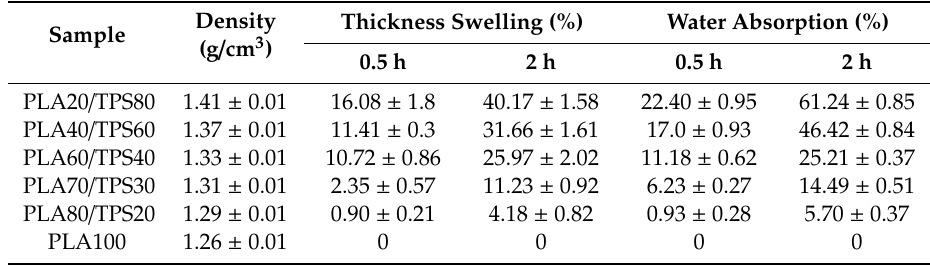
Table 4. Density, thickness swelling and water absorption of PLA100 and PLA / TPS blend bionanocomposites.